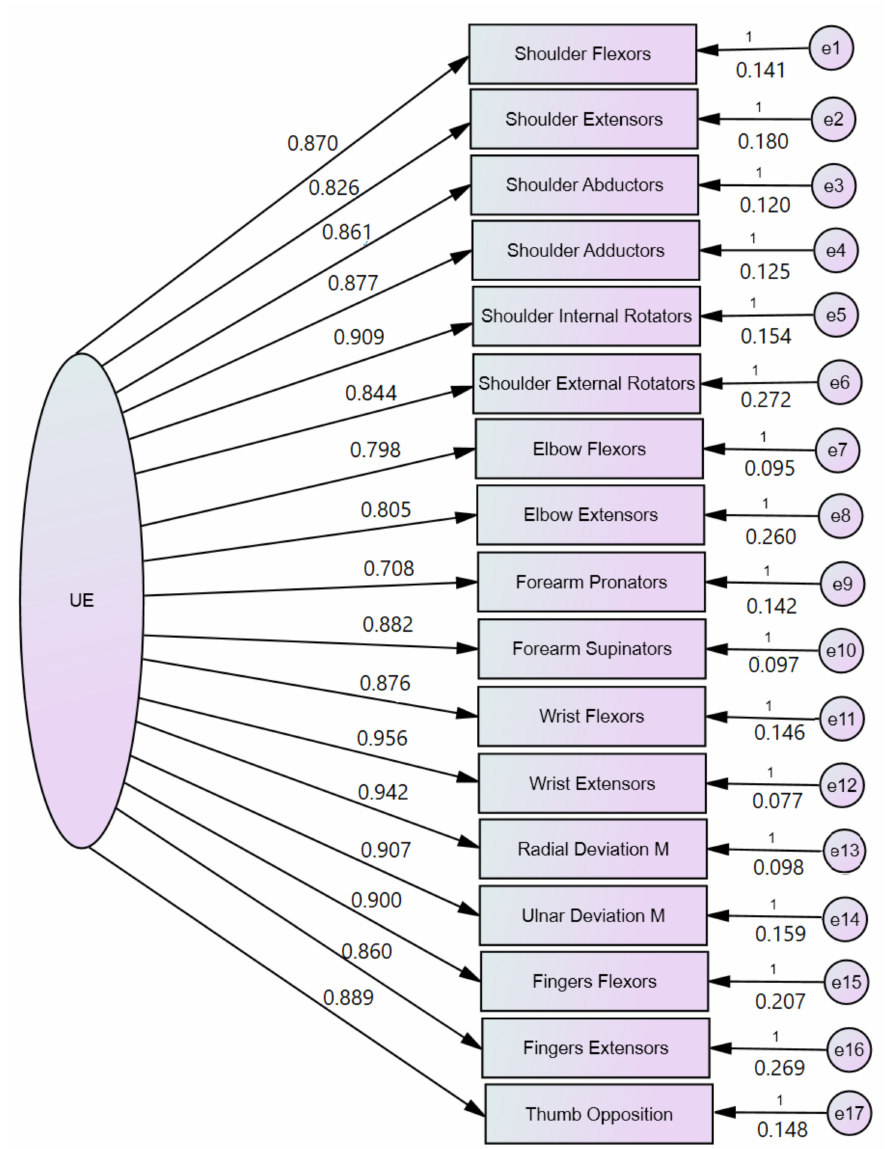
Figure 1. CFA analysis performed with structural equation modeling of the UE Manual Muscle